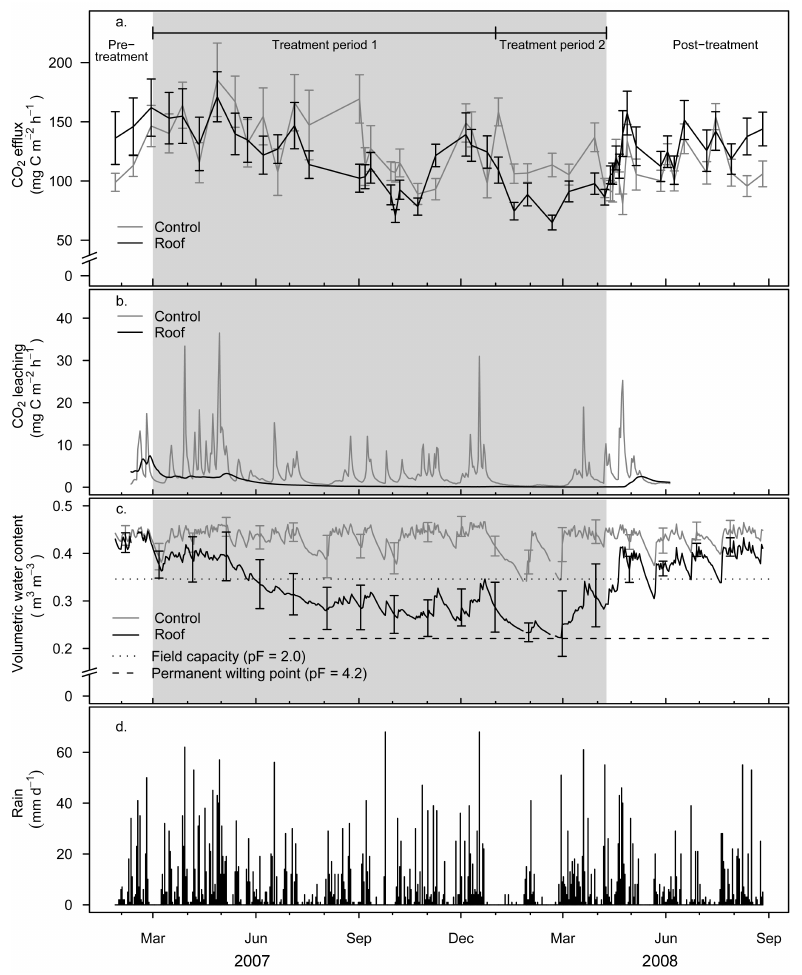
Fig. 1. (a) Average soil surface CO 2 efflux in control and roof plots, (b) average CO 2 leaching losses in control and roof plots, (c) average volumetric water content at 10cm soil depth in control and roof plots and (d) daily precipitation. Error bars indicate ± 1SE. The shaded area indicates the period of roof